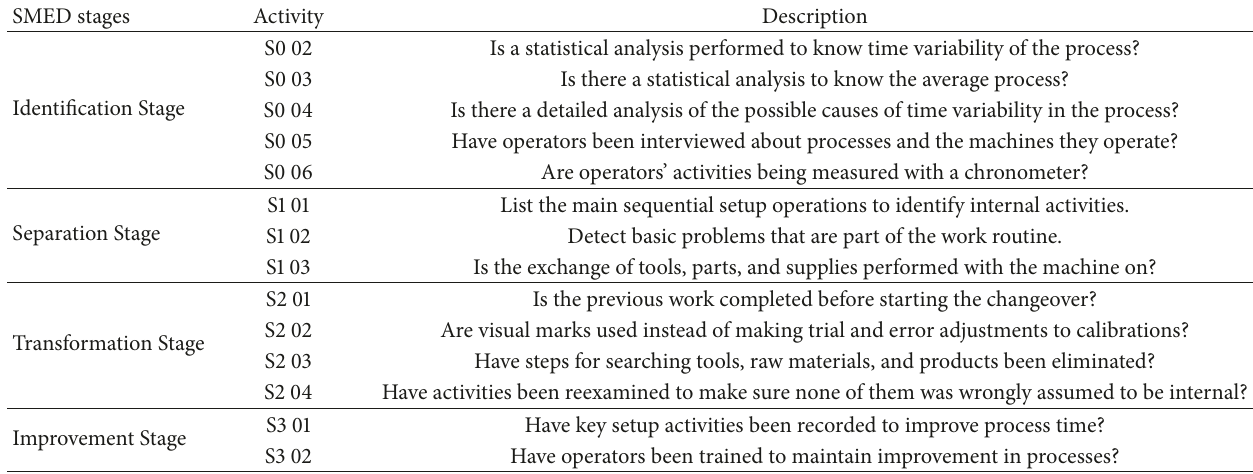
Table 1: SMED activities at its conceptual stages.